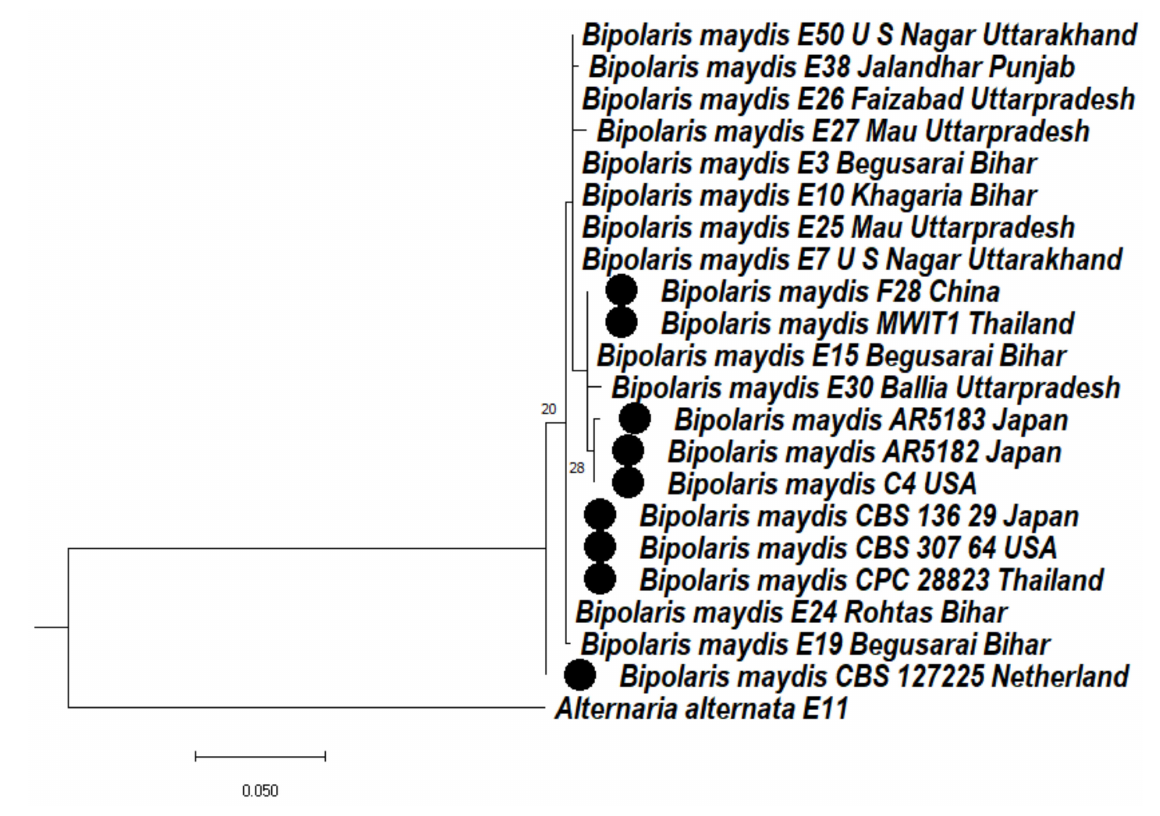
Figure 1. Dendrogram constructed from maximum likelihood method based on combined internal transcribed spacer (ITS). Sequenced data of the Bipolaris maydis isolates were inferred with Raxml based on GTR + Gamma model. Numerical value presented in the node indicates bootstrap value with a 1000 non-parametric bootstrap replicate analysis. The symbol • denotes as ‘ ex-type ’ closely related species sequences obtained from GenBank. Alternaria alternata used as an